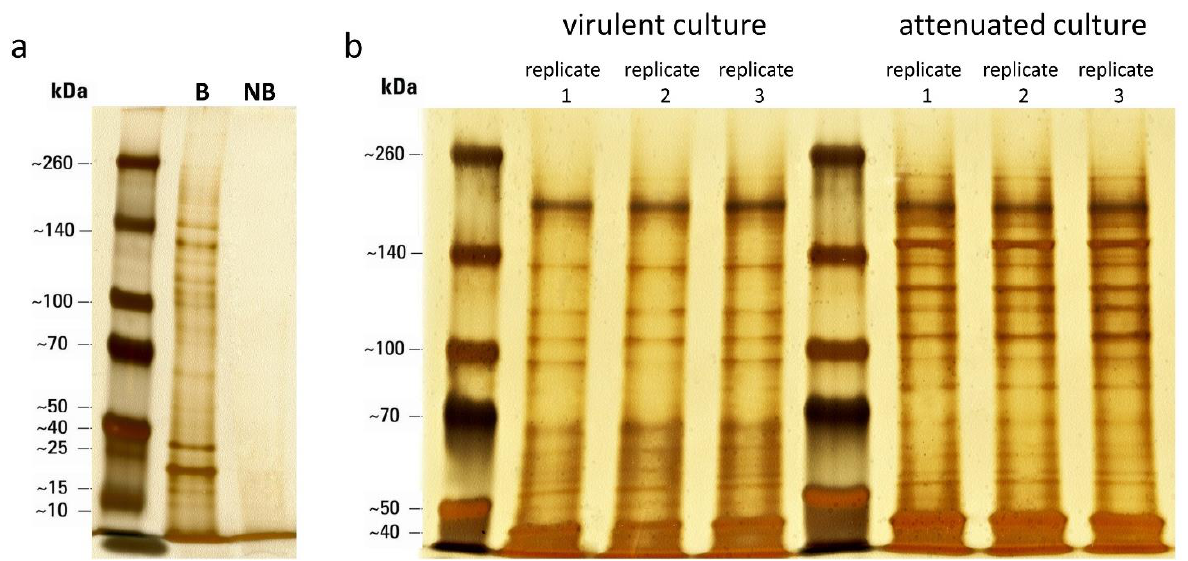
Figure 2. Biotinylation of surface-associated proteins. Proteins were separated on 8% SDS-PAGE gel and visualized by silver staining. ( a ) Results of pull-down assay using biotinylated [B] and non- biotinylated [NB] samples of H. meleagridis . ( b ) Surface-associated proteins isolated from 3 technical replicates of H. meleagridis virulent and attenuated strains.